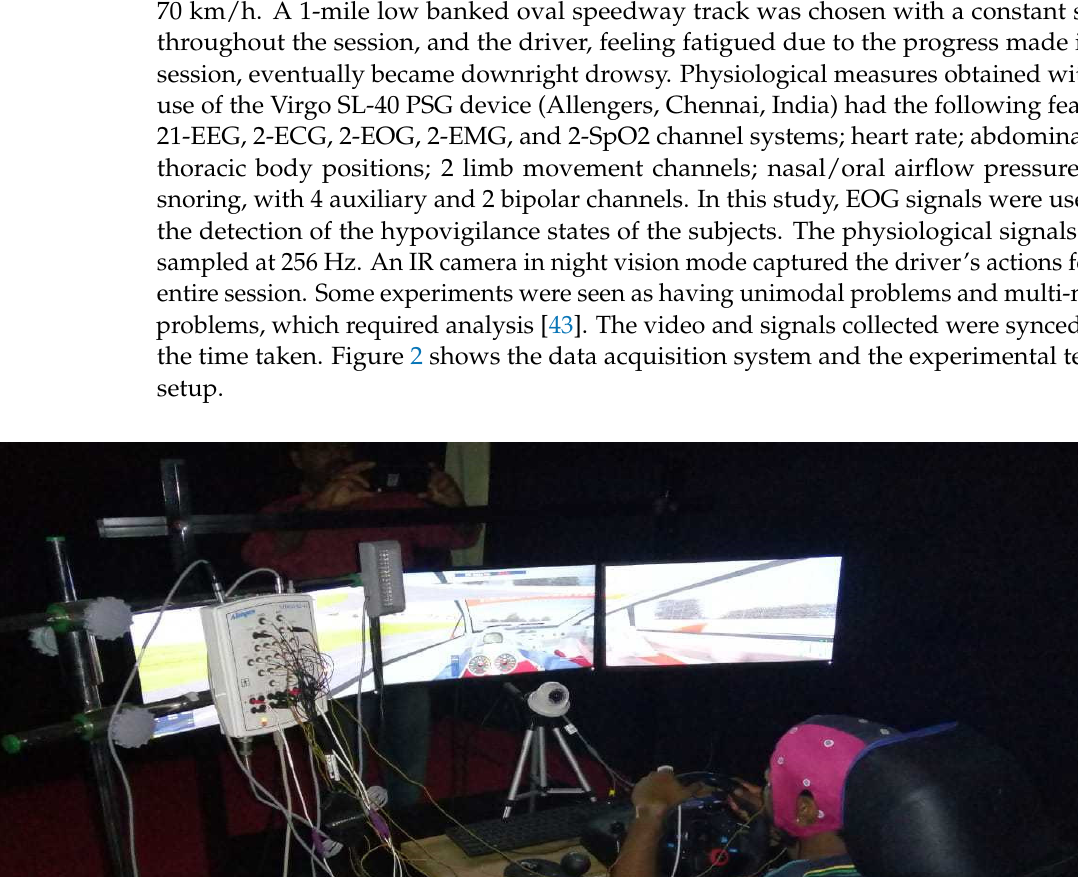
Figure 2 . Experimental setup.